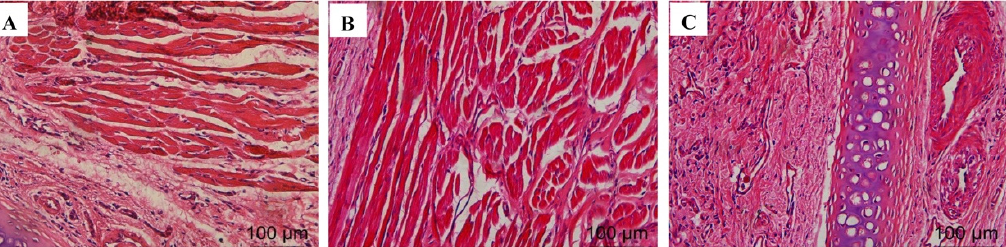
Figure 2. Nasal mucosa pathological section results of VOC-NE-ISG ( n = 4). ( A ) saline group; ( B ) VOC-NE-ISG group; ( C ) isopropyl alcohol group.